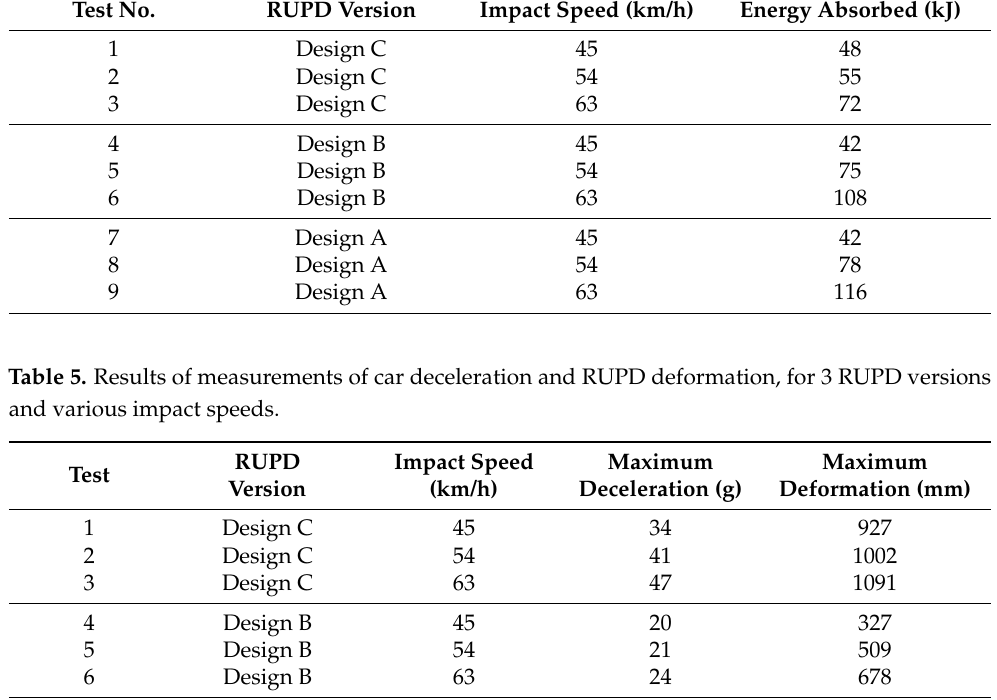
Table 4. Results of measurements of the impact energy absorbed, for 3 RUPD versions. Test No.